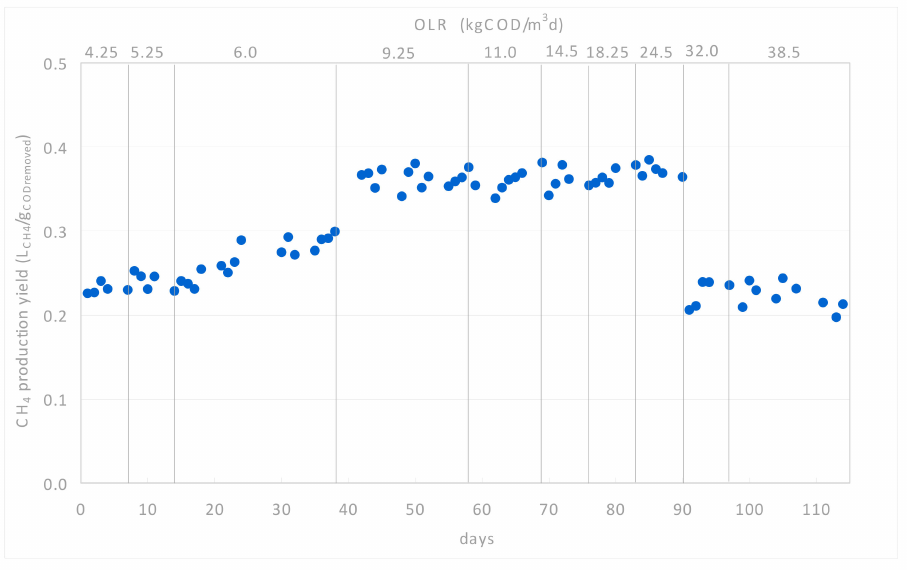
Figure 4. Methane production yield over the pilot plant operational